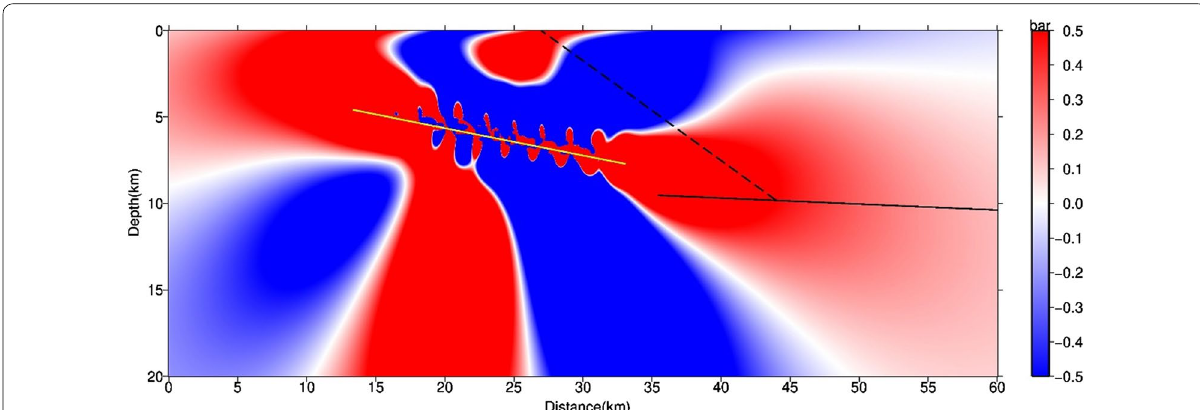
Fig. 5 Coulomb stress change along a profile across the southern margin of the Kalpingtag thrust system. The yellow line represents the planar fault we used. The black line represents the décollement fault. The dashed black line represents the Ozgertaou fault (Zhou,